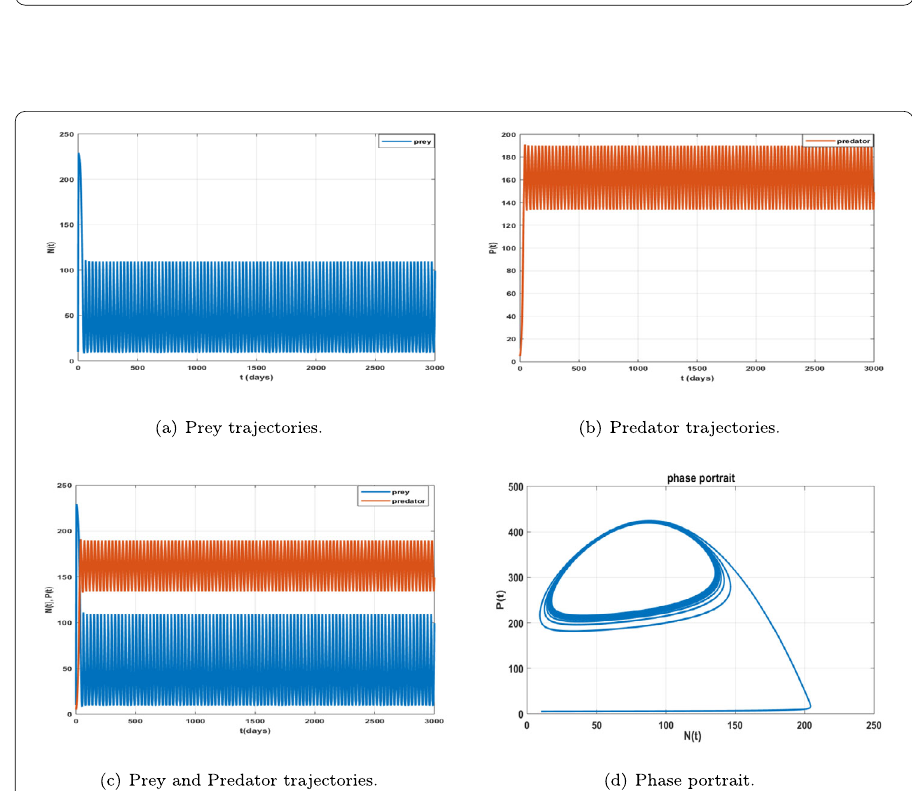
Figure 5 Dynamics of the trajectories showing the existence of limit cycle arising from the Hopf-bifurcation of system (2.3) around E 3 = ( N ∗ , P ∗ ) with δ 1 = δ 1 c =